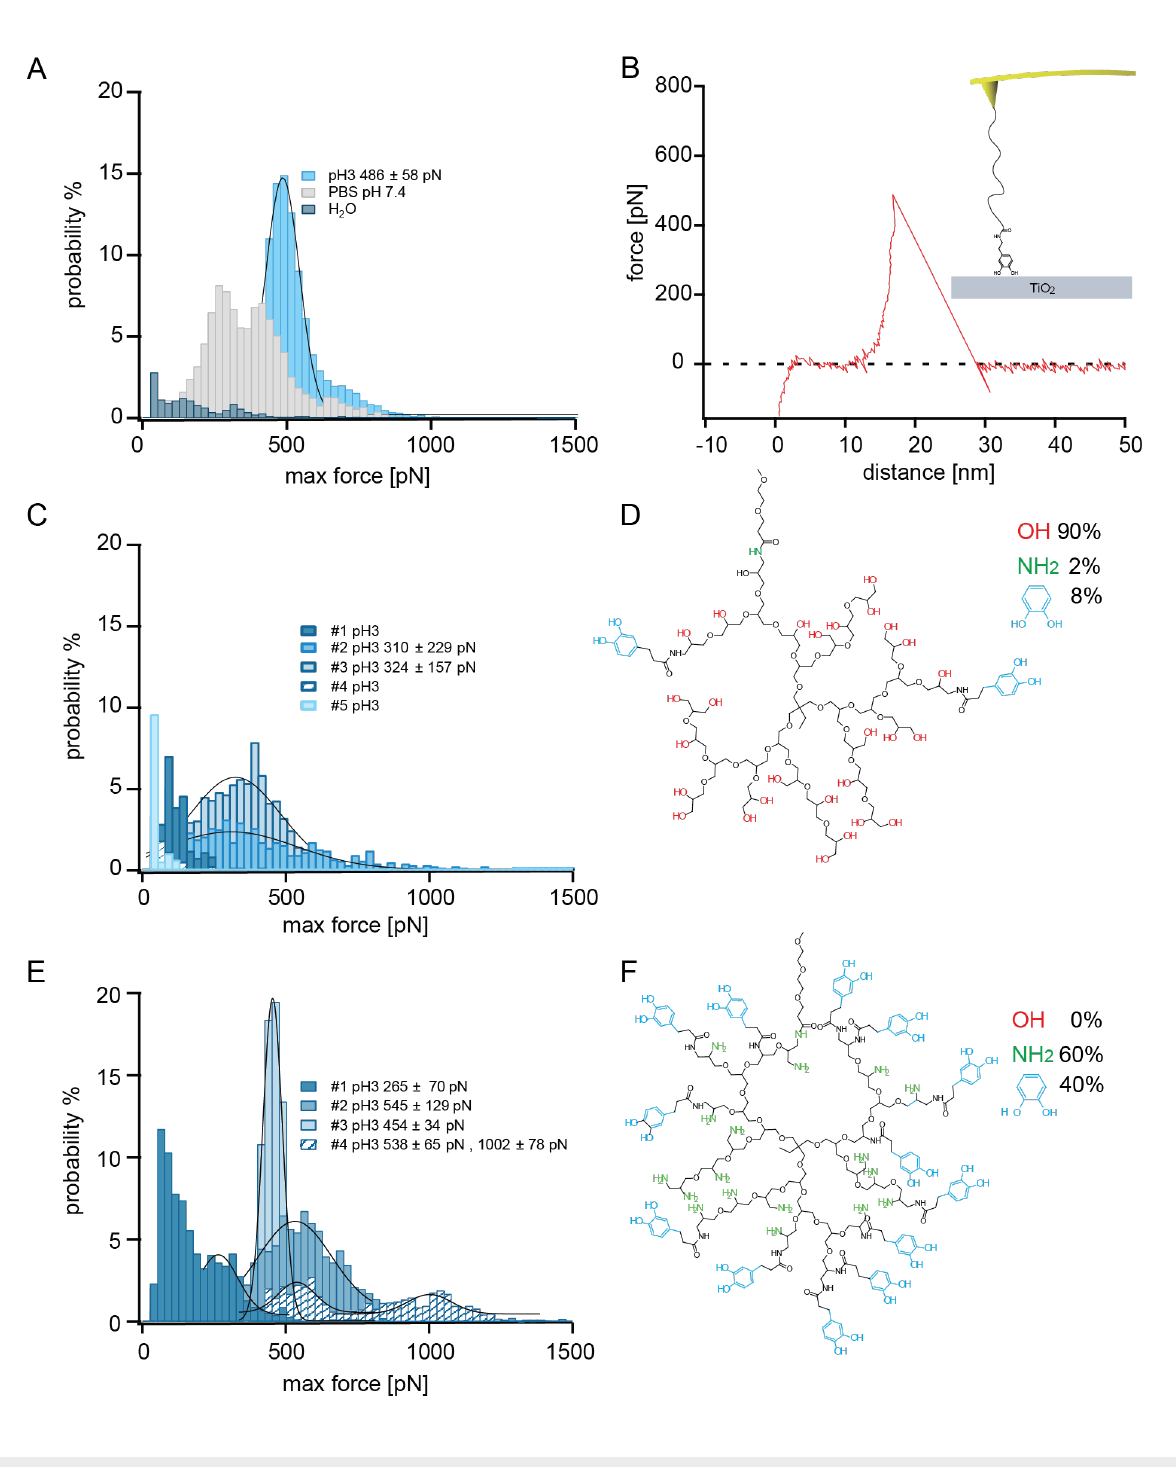
Figure 1: A) A maximum rupture force (max force) histogram for a dopamine-functionalized tip is given for the three measurement buffers: ultrapure water (dark blue), PBS (grey) and citric acid/phosphate buffer pH 3 (light blue). B) A typical retraction force–distance trace of the desorption of dopamine from TiO 2 . The inset shows a schematic of the dopamine desorption experiment. The dopamine is covalently coupled to the tip with a PEG linker using NHS ester chemistry and desorbed in buffer from TiO 2 . C) The max force histograms of 5 measurements of hPG with 8% catecholic end groups at pH 3 are depicted. D) The structure of the applied molecule. E) Max force histograms of 4 measurements at pH 3 of the hPG with 40% cate- chol end groups. F) The structure of the molecule utilized in (E), where possible peaks in the max force histograms were fitted and the peak value as well as the standard deviation are given in the